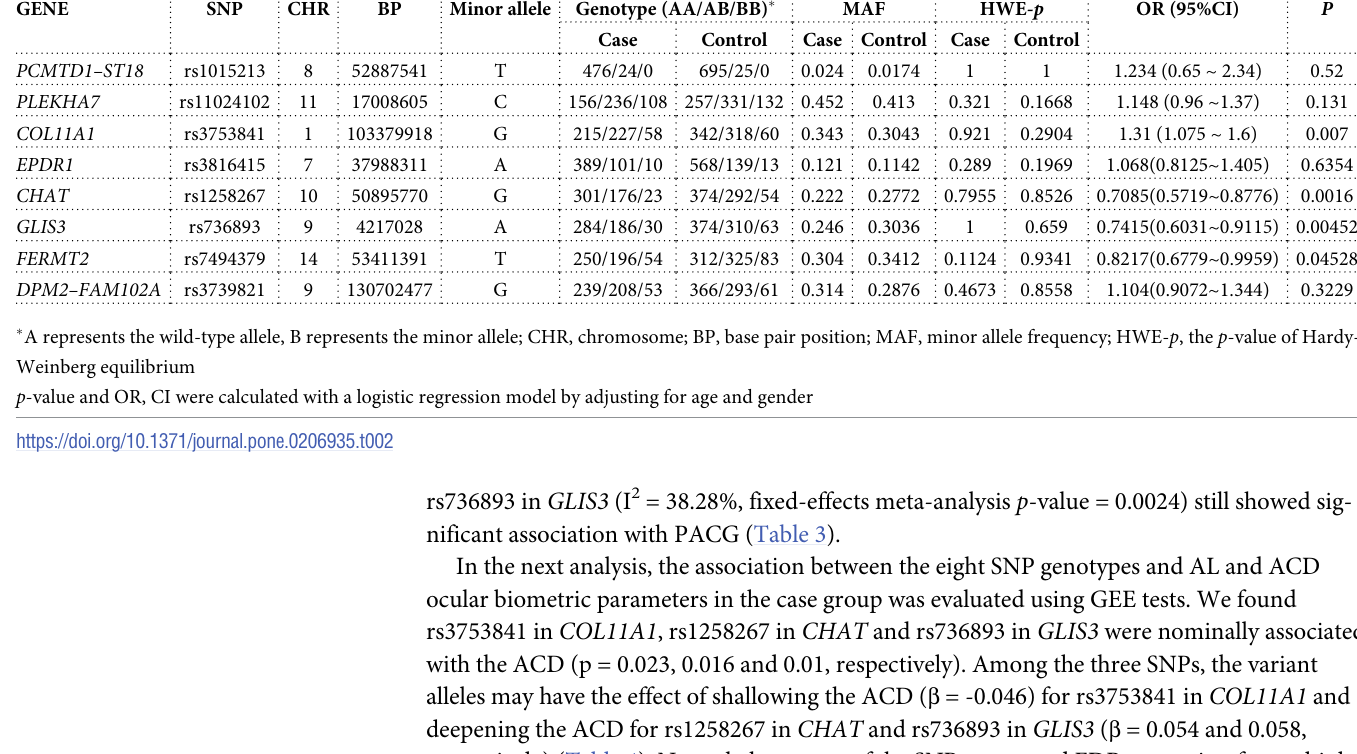
Table 2. Association of target SNPs with PACG after adjustment for age and gender. GENE